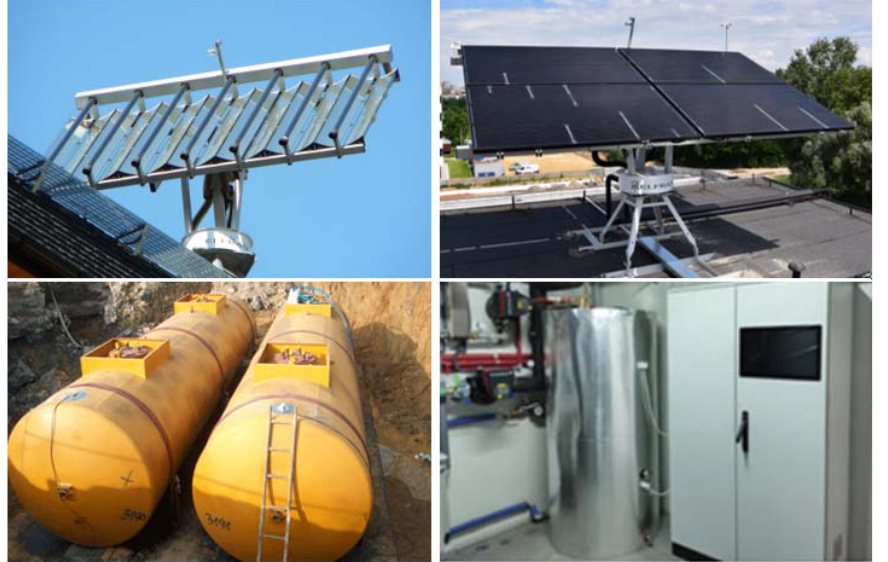
Figure 6. Elements of existing SOPSAR system, solar tracked collectors manufactured by the Elfran company (top left corner), solar tracked PV ‐ T panels manufactured by the Elfran company (top right corner), underground heat storage tanks (bottom left corner), and heat pump (bottom right corner). Reprinted with permission from ref. [23]. 2021 Oc ł o ń .